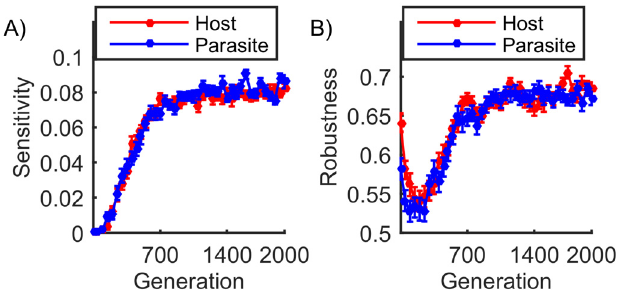
part of the network was defined as the fraction of mutations that leave the phenotype unchanged if we exclude phenotype inversions (see main text). Both plots show mean values for 100 simulations with the error bars indicating standard error of the mean